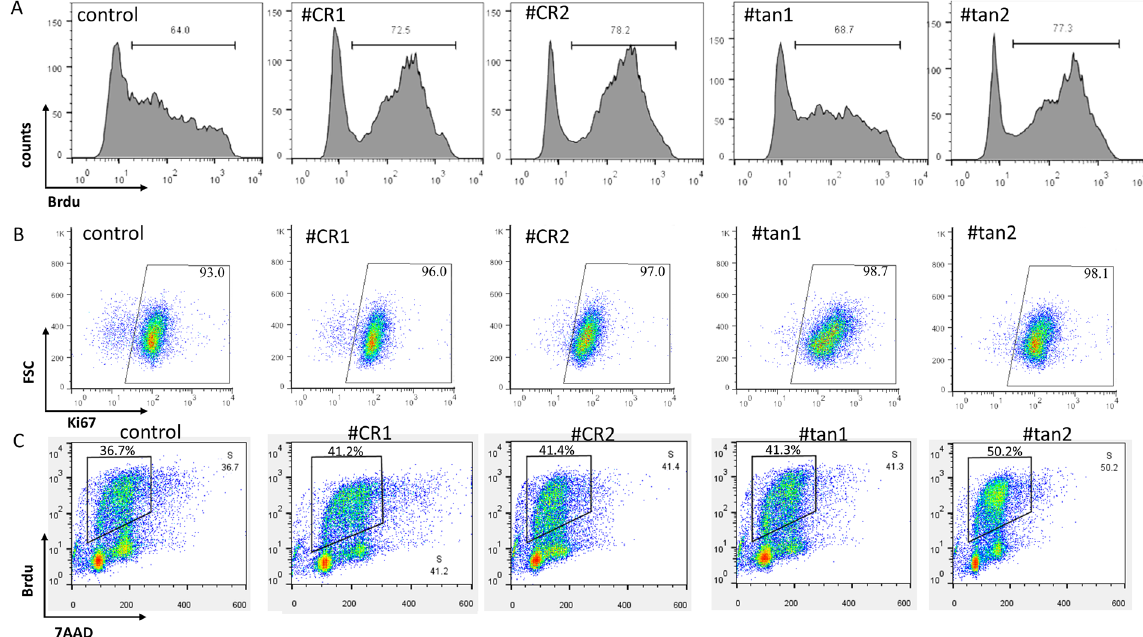
Figure 4. APA switching of CCND1 promotes cell proliferation. ( A ) Cell proliferation was assessed by BrdU assay with flow cytometry. The proportions of proliferative cells are shown. ( B ) Proportion of Ki67 positive cells in mutant cells. Gates were set using isotype control antibodies. ( C ) Quantification of cell-incorporated BrdU and total DNA content